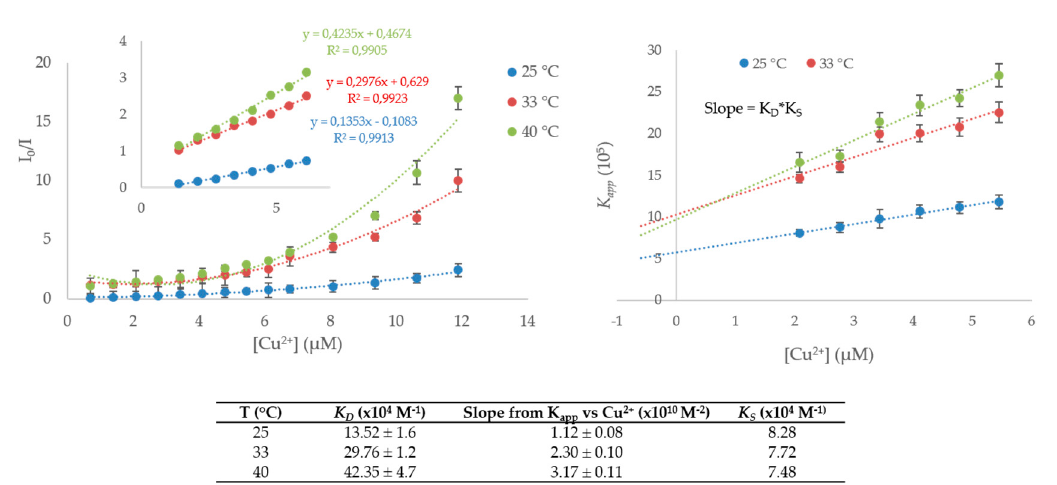
Figure 9. ( Left ) Stern–Volmer plots for the titration of compound 1 with Cu 2 + at di ff erent temperatures. ( Right ) Modified Stern–Volmer plots. Each experiment was performed in triplicate. The obtained quenching constants are listed in the table.